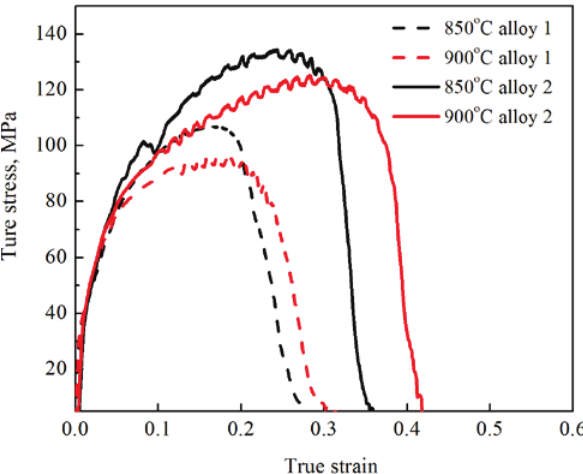
Fig. 8: True stress-strain curves as a function of the tensile temperature for tested